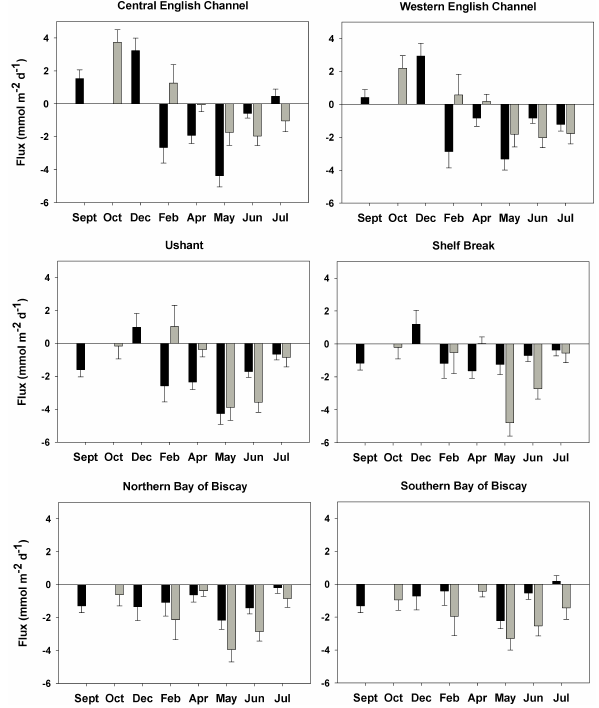
Fig. 6. Calculated monthly air-sea CO 2 fluxes (mmolm − 2 d − 1 ; negative values indicate a net flux into the sea) for each region in 2005/2006 (dark grey) and 2006/2007 (light